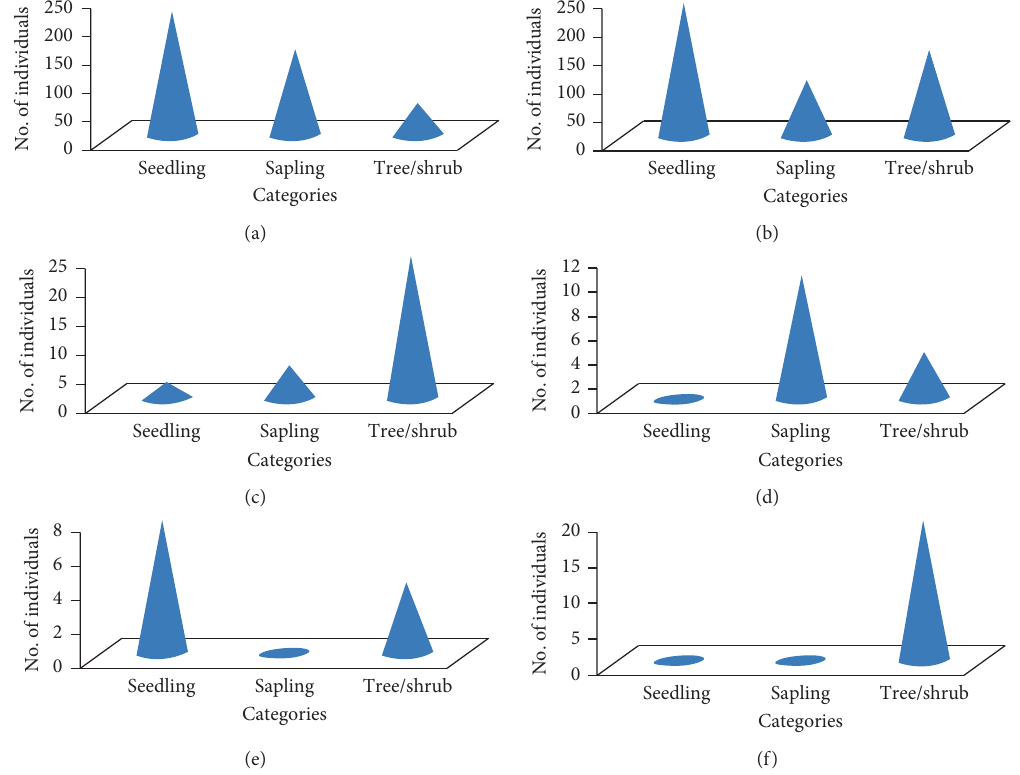
Figure 3: (a–f) Seedlings, saplings, and tree/shrub distribution of some selected species occurring in Agama Forest. (a) Coffea arabica . (b) Vepris dainellii . (c) Ficus sur . (d) Flacourtia indica . (e) Buddleja polystachya . (f) Schefflera abyssinica .